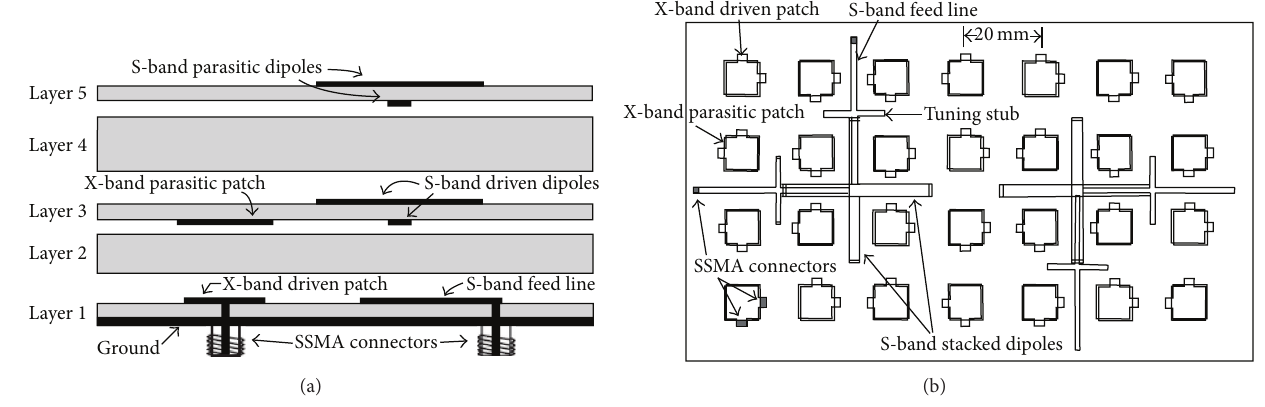
Figure 28: Dual-band dual-polarized antenna array: (a) side view and (b) top view